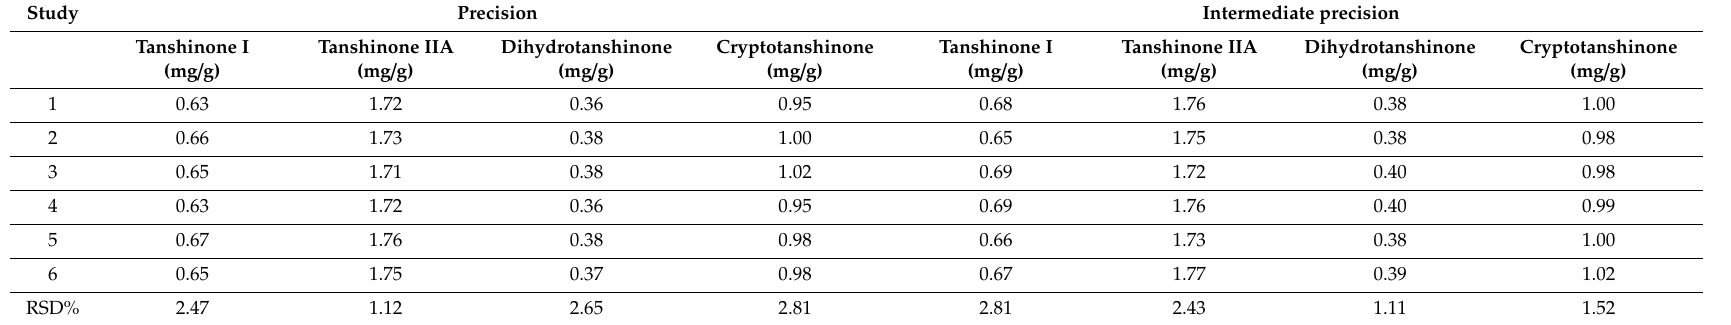
Table 4. Precision and intermediate precision test results